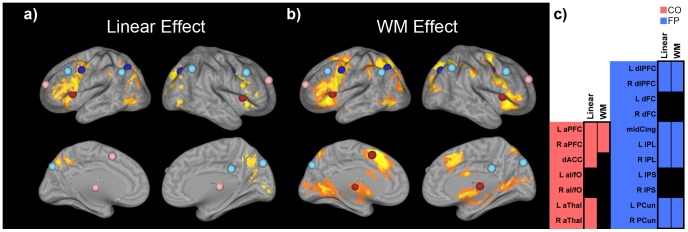
Univariate group maps of cognitive control-related contrasts during the Selective WM task.a) Linear effect (Categorize trials < Select Relevant trials < Select Both trials); b) WM effect (all relevant trials – all irrelevant trials). Overlaid on the group maps are the intrinsic CO (in red/pink) and the intrinsic FP (in blue/light blue) ROIs. Red and blue ROIs depict intrinsic ROIs that overlapped with significant activity related to the contrasts. Pink and light blue ROIs depict intrinsic ROIs that did not overlap with significant activity related to the contrasts. c) Overlap between univariate group maps and intrinsic ROIs (CO ROIs shaded in red; FP ROIs shaded in blue; black squares indicate overlap).